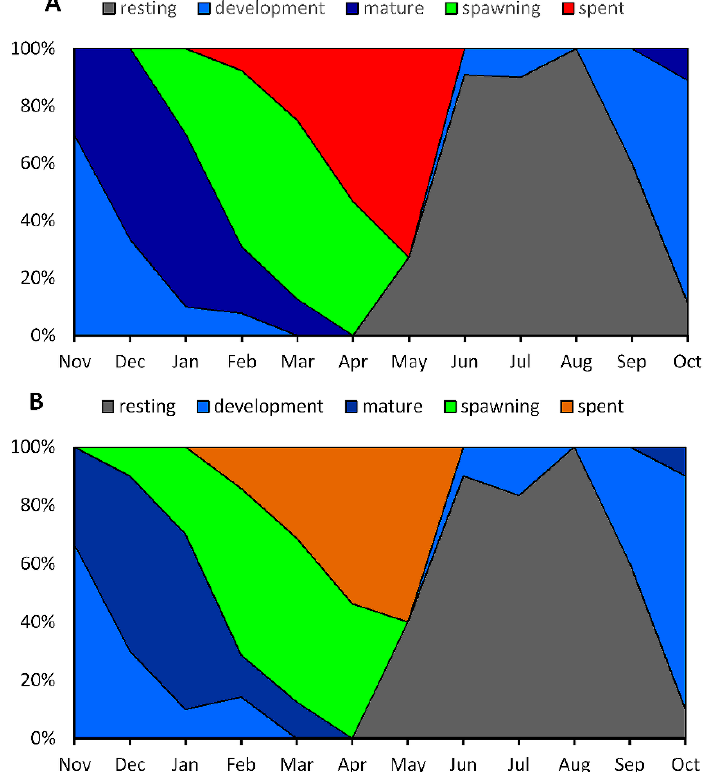
Figure 3. Monthly variations of gonadal maturity stages (%) in female ( A ) and male ( B ) Perna viridis collected from the coastal waters of Bangladesh during November 2017 to October 2018.